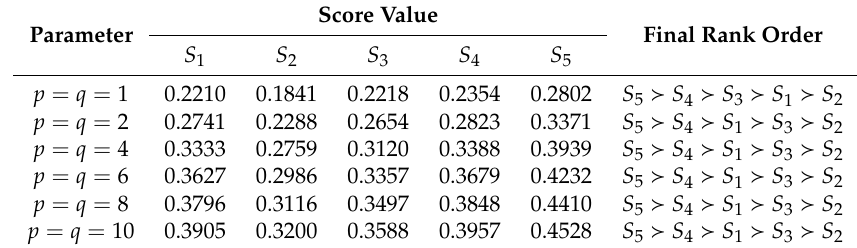
Table 4. Score values using WSVNPHM operator.